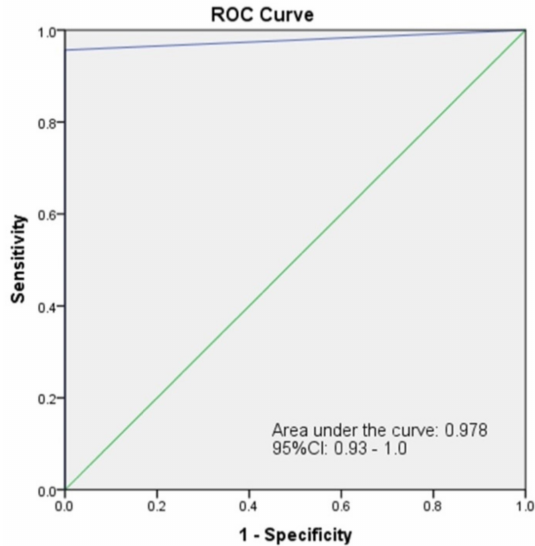
Figure 4. ROC analysis of the agreement between the RT-RPA-NALF assay and RT-qPCR